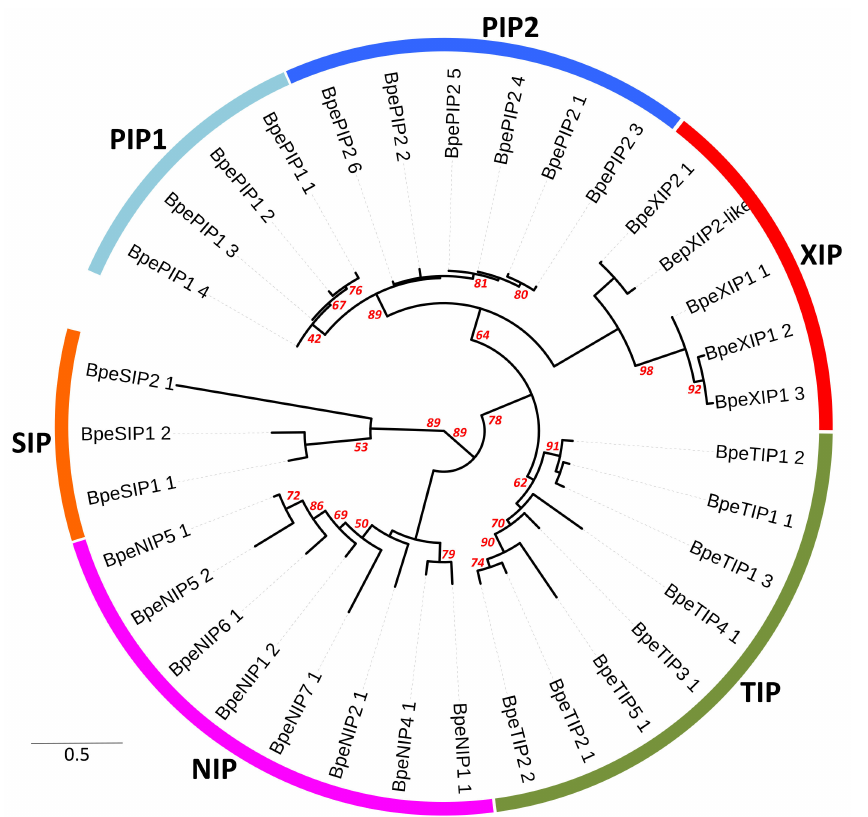
Figure 1. Phylogenetic analysis of the Bpe AQP full-length and the truncated Bpe XIP2;1-like protein sequences from Betula pendula . Deduced amino acid sequences were aligned using ClustalW, and the phylogenetic tree was constructed using the maximum parsimony method. Maximum parsimony analysis was conducted using the subtree-pruning-regrafting algorithm. The number next to the branch’s nodes represents bootstrap values ≥ 50% based on 5 000 resamples. The distance scale denotes the number of amino acid substitutions per site. The name of each subfamily is indicated next to the corresponding group. The Bpe AQP accession numbers and sequences are listed in Figure S1 and Table S1. The complete phylogenetic analysis of aquaporin family proteins of Betula pendula ( Bpe AQPs, filled circles) with the AQP sequences from Arabidopsis thaliana ( At AQPs), Lycopersicon esculentum ( Sl AQPs), Olea europaea ( Oeu AQPs) and Populus trichocarpa ( Poptr AQPs) is proposed in Figure